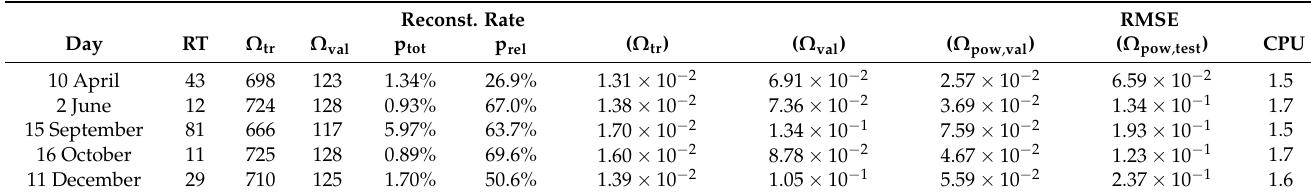
Table 3. Reconstruction results on days from the Sample_100 group. The reported statistics are averaged over 50 runs. Reconst.